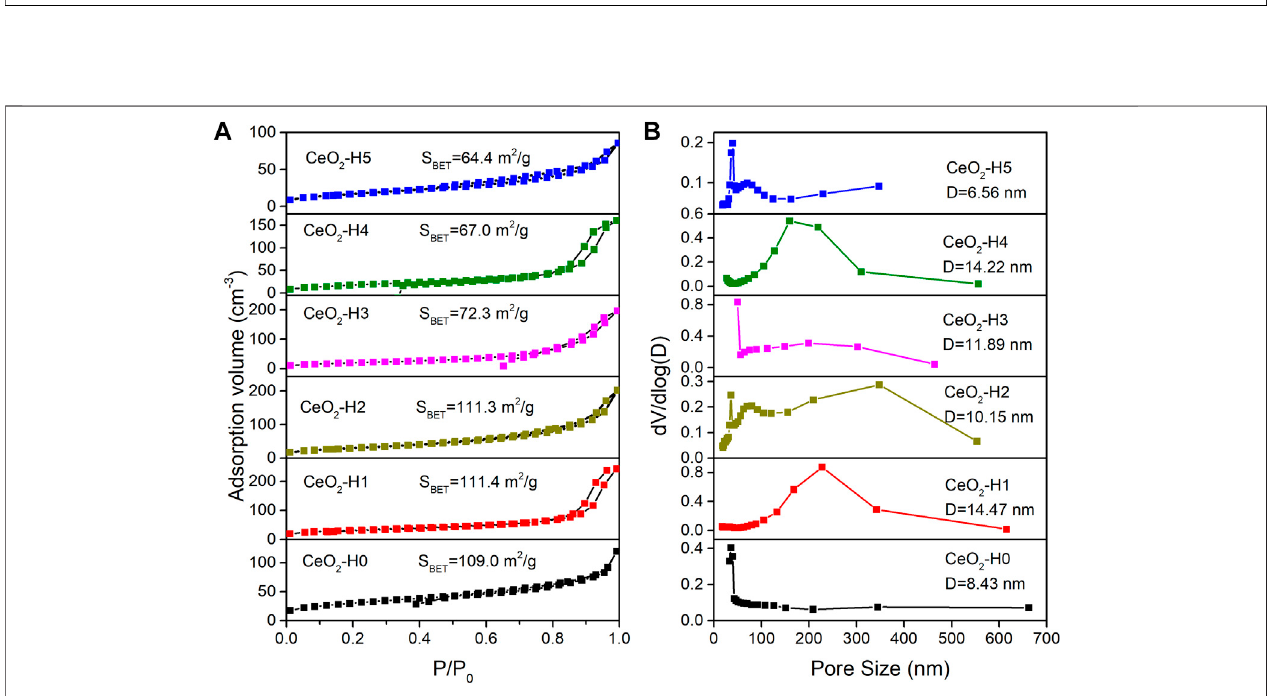
FIGURE 4 | N 2 sorption isotherm (A) and pore size distribution (B) of CeO 2 prepared by the combined microwave – ultrasonic method and calcined at 500 ° C in air for 1 h.